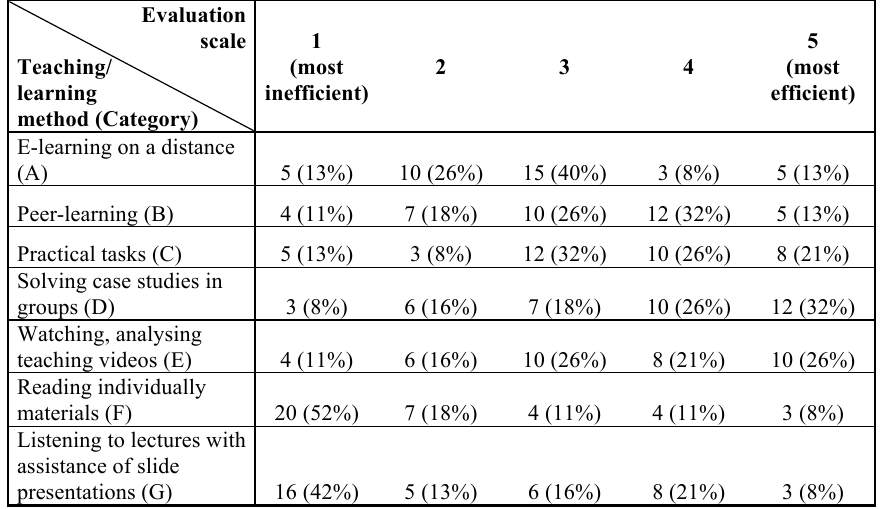
Table 2. Teaching methods evaluation (CLUSTER